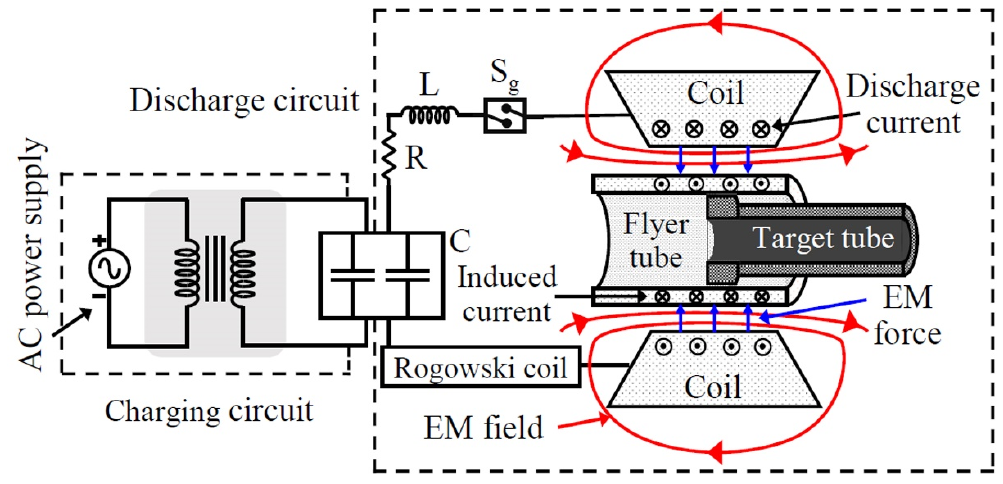
Figure 1. Schematic layout of magnetic pulse welding (MPW) set-up for joining of tubes.